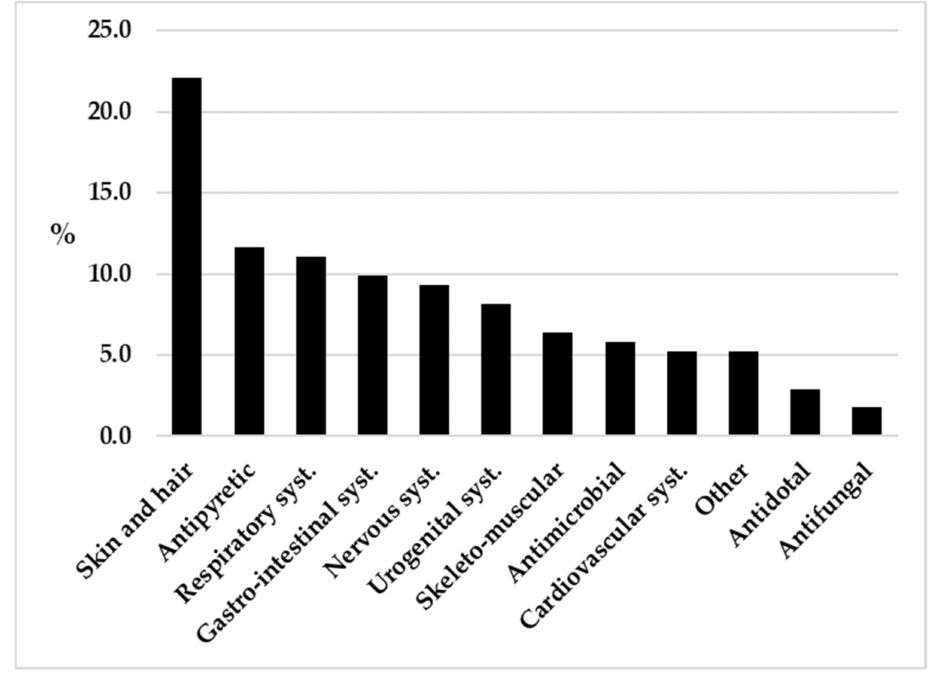
Figure 2. Ailments categories for which bryophytes are used. Different preparations and application processes of medicinal bryophytes were men- tioned for topical uses. As shown in Figure 3, the majority of these remedies involved treatments for healing wounds, burns, boils, abscesses, bruises, and